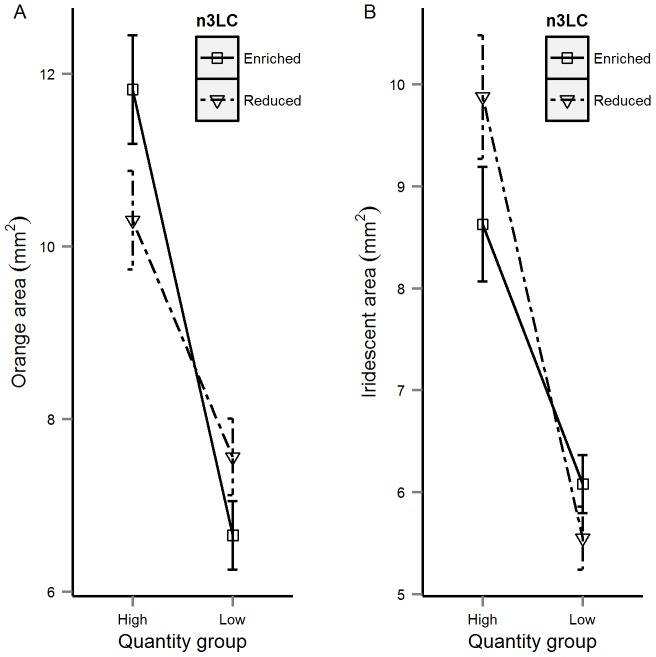
The quantity-by-n3LC interaction effect (mean ± SE) on (A) orange area and (C) iridescent area.